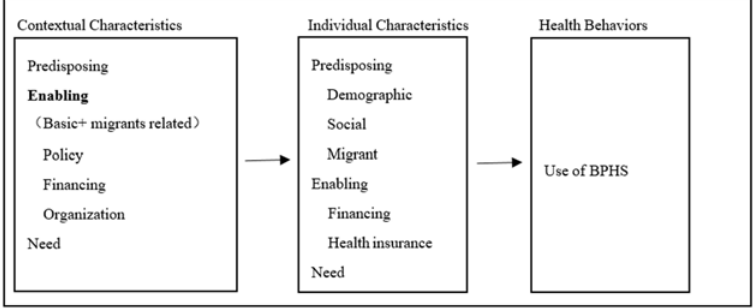
Figure 2. The simplified Andersen’s model of health services use.